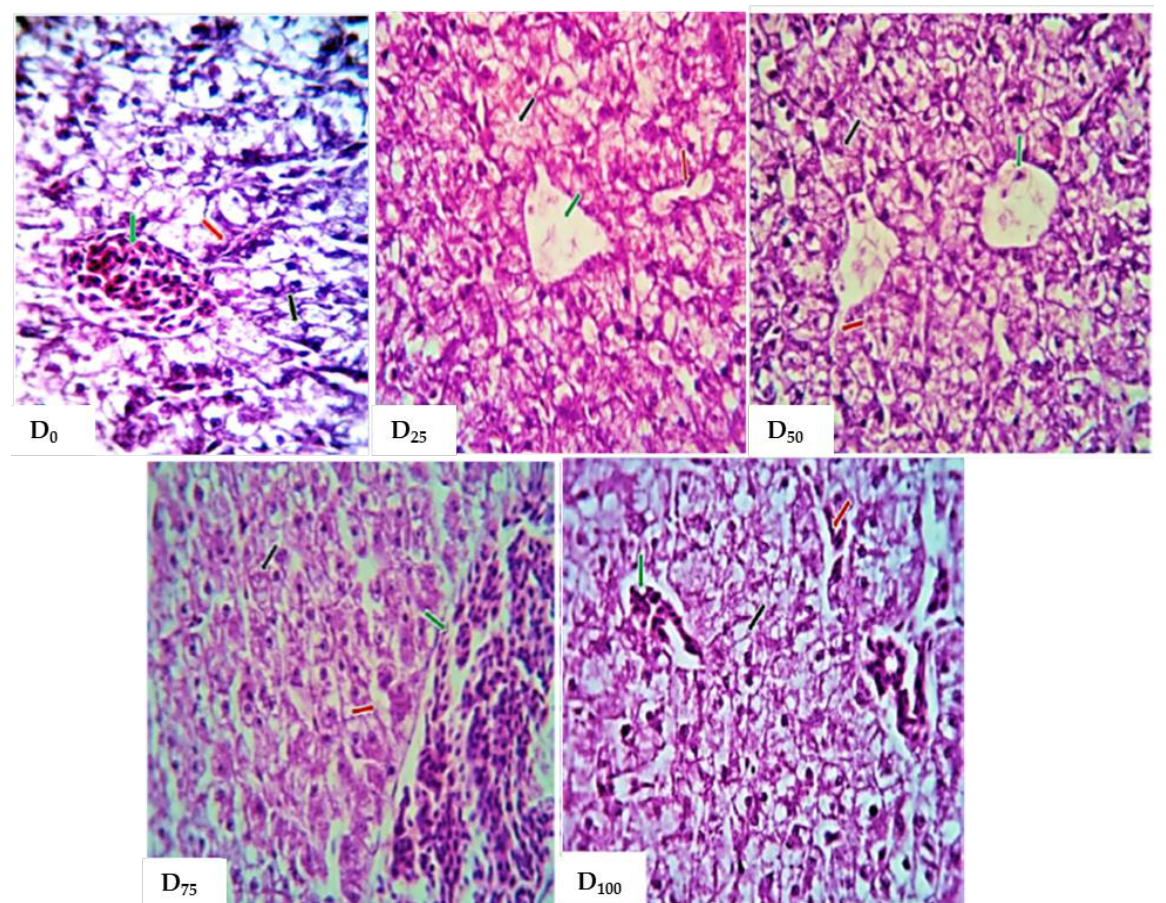
Figure 2. Photomicrograph of the effect of partial or total replacement of fishmeal by amphipod meal, Gammarus pulex , on the liver histology of Mugil cephalus. D 0 showing normally organized hepatic lobules with indistinct boundaries, radially arranged hepatic cords (black arrows) around a well-formed thin-walled central vein (green arrow). Hepatic sinusoids are seen among the hepatic cords (red arrows) for groups fed (D 25 , D 50 , D 75 , and D 100 ) as in the control group. (hematoxylin and eosin staining, X 400). Table 8. Cost-profit analysis of Mugil cephalus fed on experimental diets.